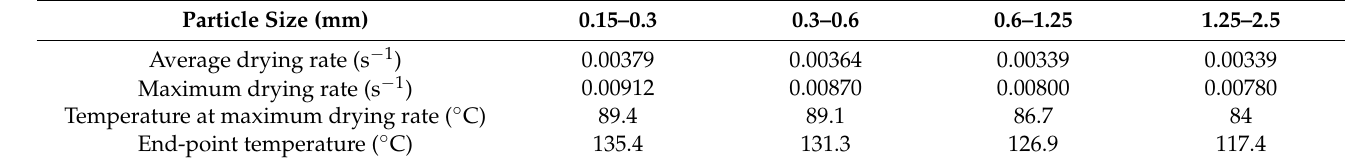
Figure 11. Effects of particle size on the ( a ) moisture ratio and ( b ) drying rate of CRES in the microwave drying process. Table 6. Variations of microwave drying characteristics of CRES with particle size.